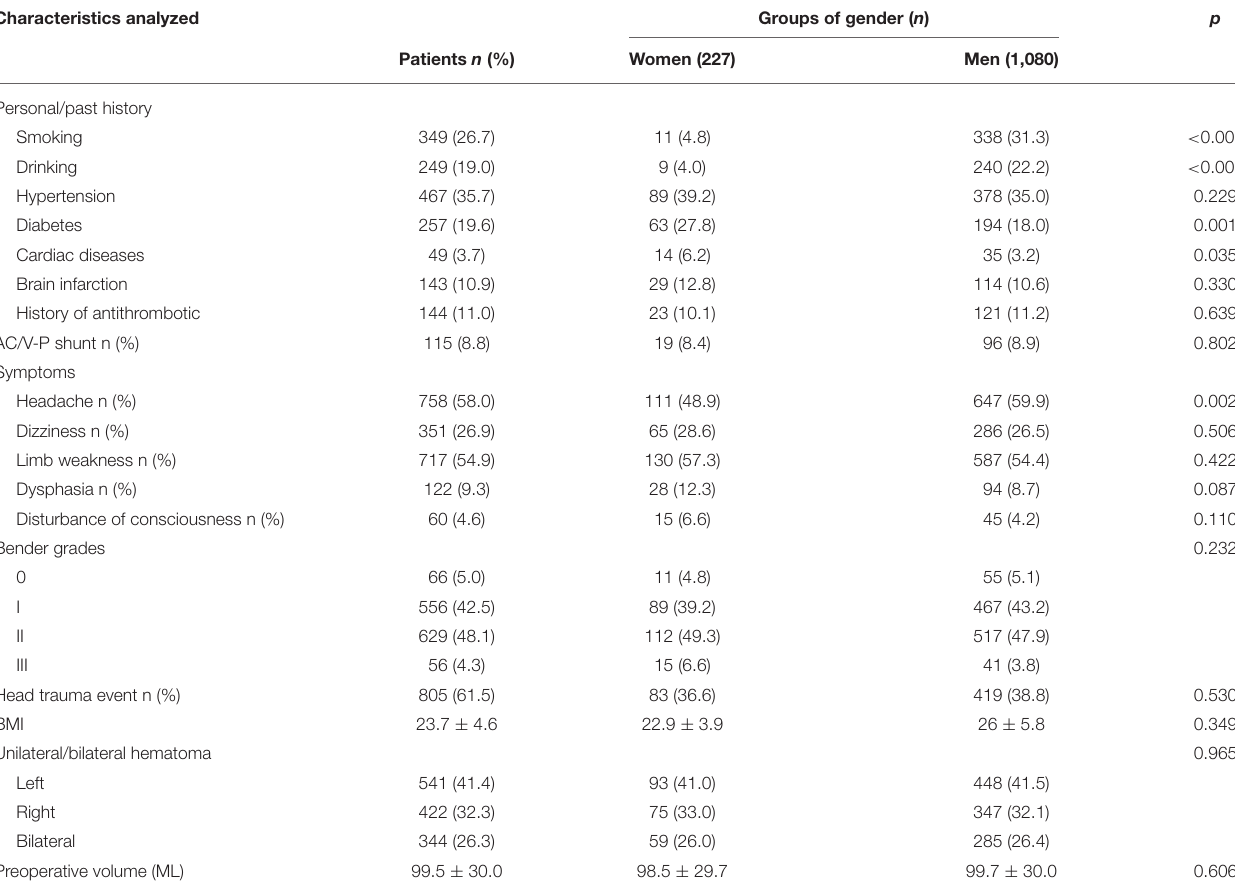
TABLE 1 | The clinical characteristics and relationship between clinical characteristics and groups of gender in patients with chronic subdural hematoma. Characteristics